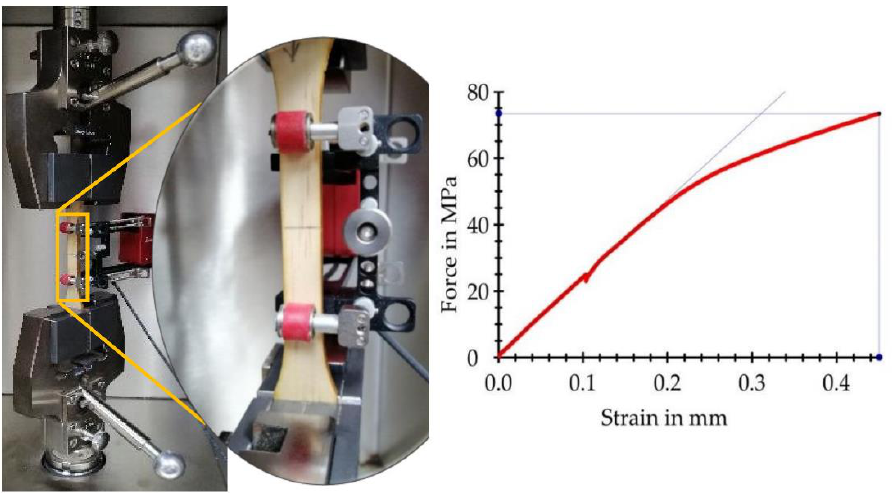
Figure 2. Clip-on extensometer. Determination of the force at the proportional limit.